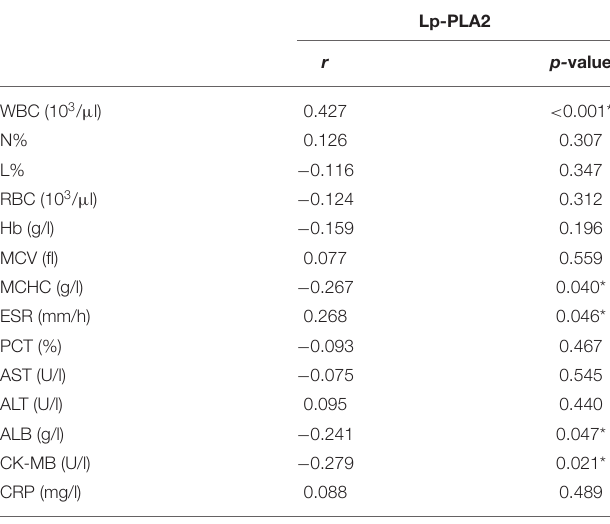
TABLE 2 | Correlations between serum Lp-PLA2 levels and general laboratory variables in KD group.